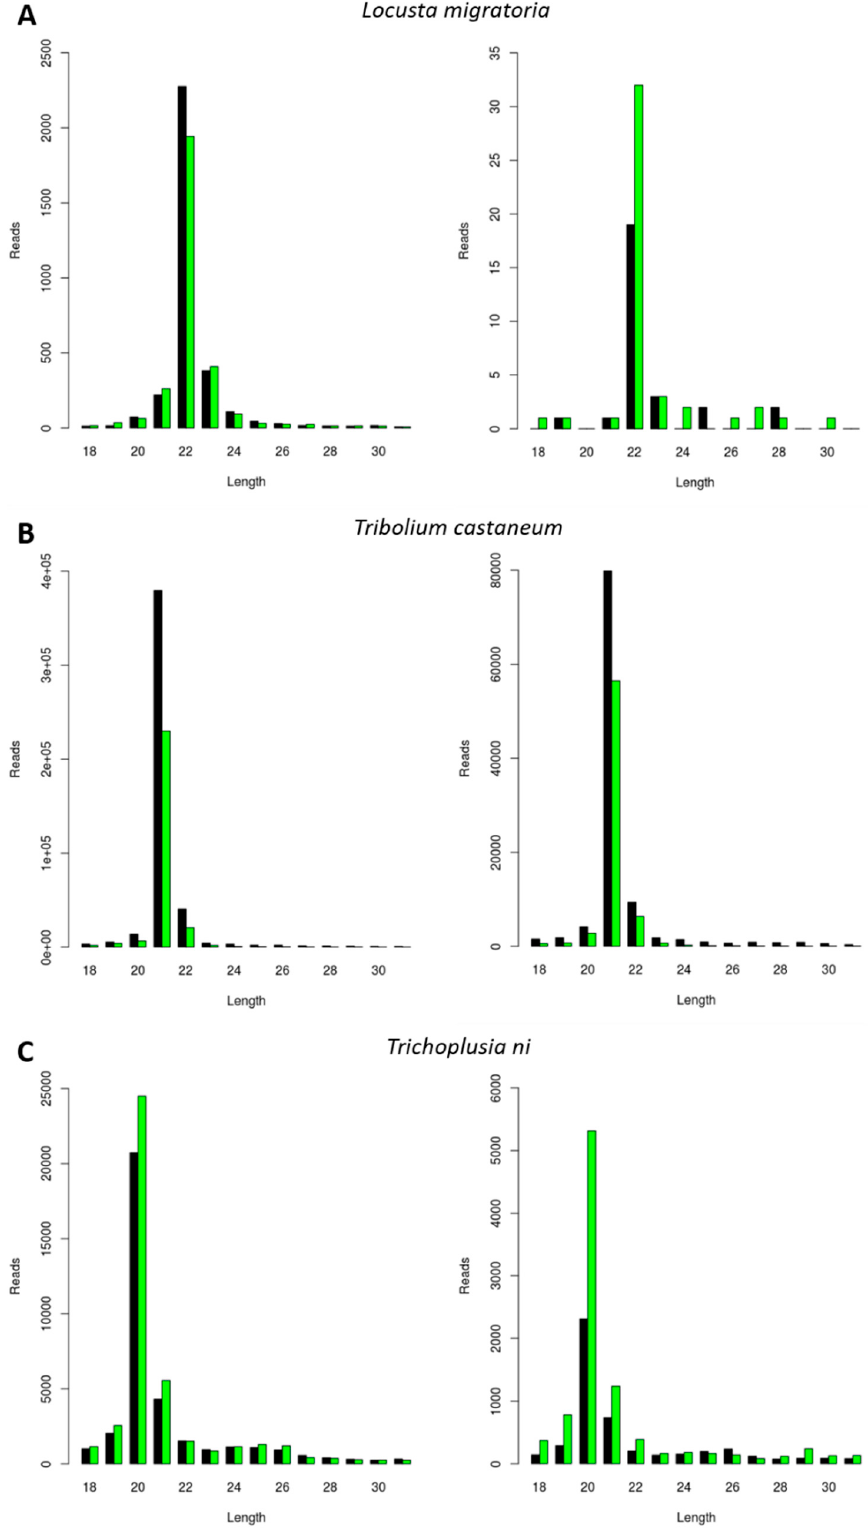
Figure 2. Generation of Flock House Virus (FHV)-derived siRNAs with species-dependent length distribution. Length distribution of small RNAs mapping to FHV, derived from fat body of FHV-infected L. migratoria ( A ), as well as from FHV-infected Tribolium castaneum TcA cells ( B ) and from persistently FHV-infected Trichoplusia ni High Five cells ( C ). Left: FHV RNA1. Right: FHV RNA2. Reads ( y axis): number of reads. Length ( x axis): length (nt) of the reads. Black: sense reads. Green: